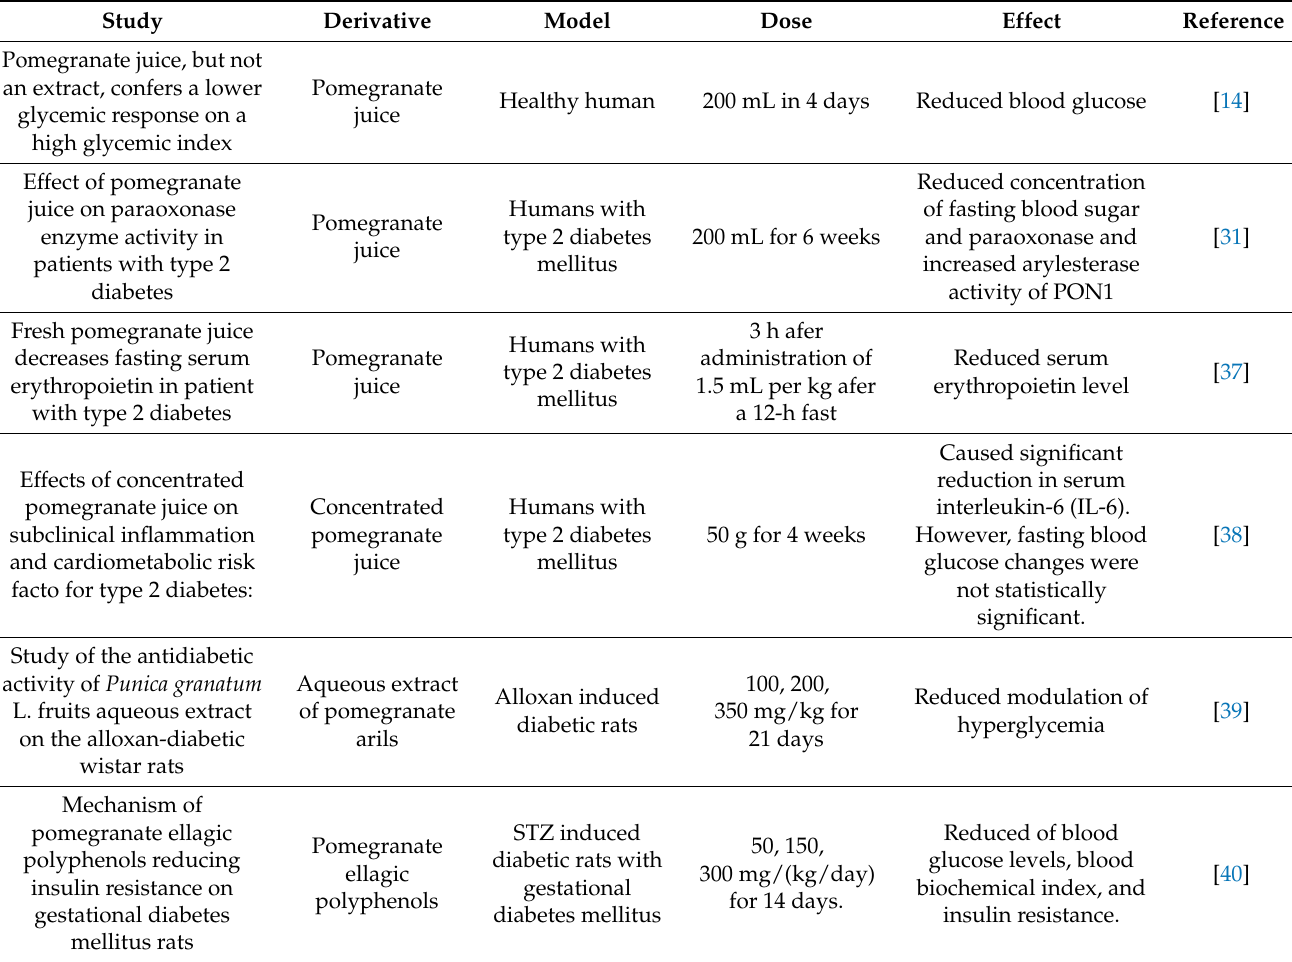
Table 2. Effect of pomegranate juice and its extracts on type 2 diabetes using in vivo and vitro